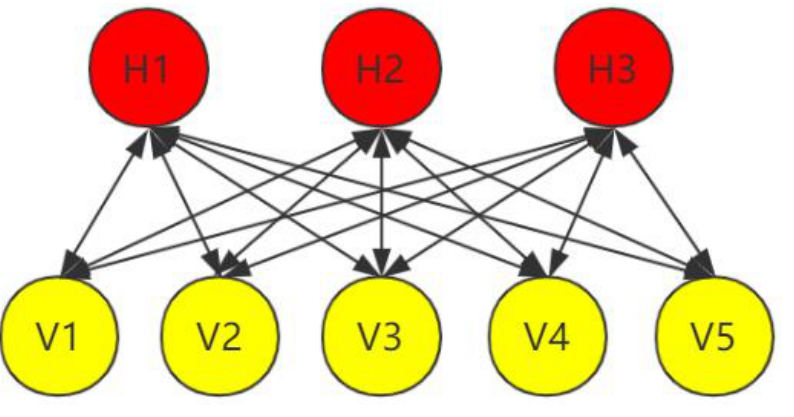
Figure 9. Single-layer RBM.